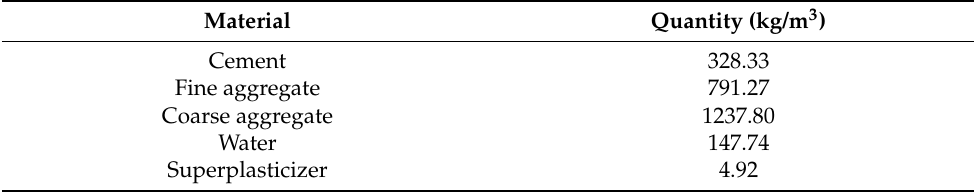
Table 2. Mix specifications for M40 grade of